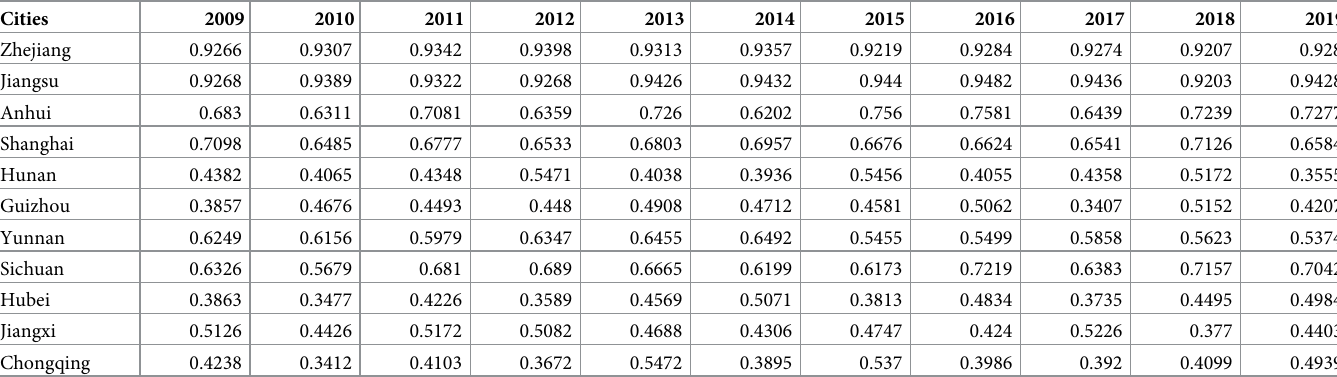
Table 2. Logistic industry comprehensive index value for various regions.